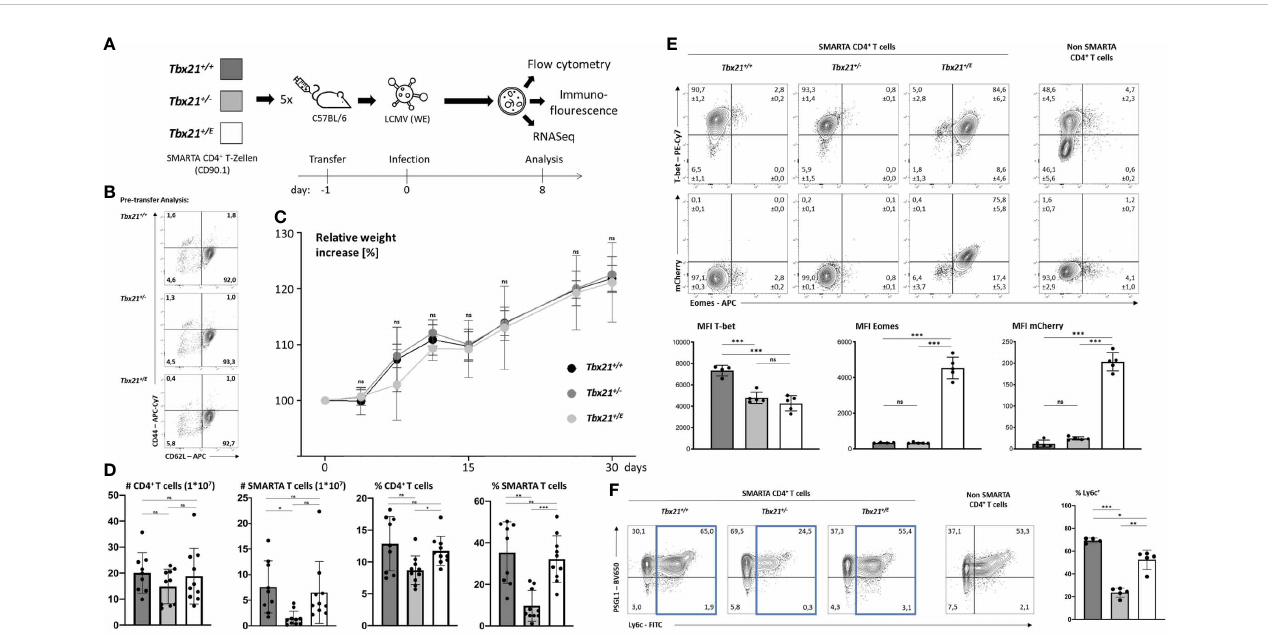
FIGURE 2 Eomes promotes a distinct phenotype in CD4 + T cells during acute infection. (A) CD4 + T cells were puri fi ed and 2x10 4 cells were transferred into fi ve C57BL/6 mice per genotype. After 24 hours mice were infected with 200 pfu LCMV (WE). On day 8 after infection cells were counted and analysis was performed by fl ow cytometry, immuno fl uorescence microscopy or sorting of CD90.1 positive SMARTA CD4 + T cells and RNA sequencing. (B) Pre- transfer analysis and con fi rmation that naïve CD4+ T cells (CD62L + CD44 - ) were transferred. (C) Relative weight increases in relation to date of infection. (D) Cell numbers of CD4 + T cells (CD4 + CD90.2 + ) and SMARTA CD4 T cells (CD4 + CD90.1 + ) were calculated by multiplying absolute cell numbers with the percentages measured by fl ow cytometry. Dots in the bar diagrams represent individual mice out of two independent experiments. (E) Intranuclear staining of T-bet and Eomes shown in dot plots and the MFI in bar diagrams. (F) Surface staining of Ly6c and PSGL-1 shown in dot blots and MFI in bar diagrams. SMARTA CD4 + T cells were identi fi ed as CD4 + CD90.1 + . Endogenous non-SMARTA CD4 + T cells (CD4 + CD90.1 - ) were used as a staining control and for setting quadrant gates in (E, F) . Statistical analysis: *=p < 0.05; **=p < 0.01; ***=p < 0.001; ns, not signi fi cant; Error bars denote mean + SEM. n=2 with 4-5 mice per group. If not otherwise indicated, one representative experiment is